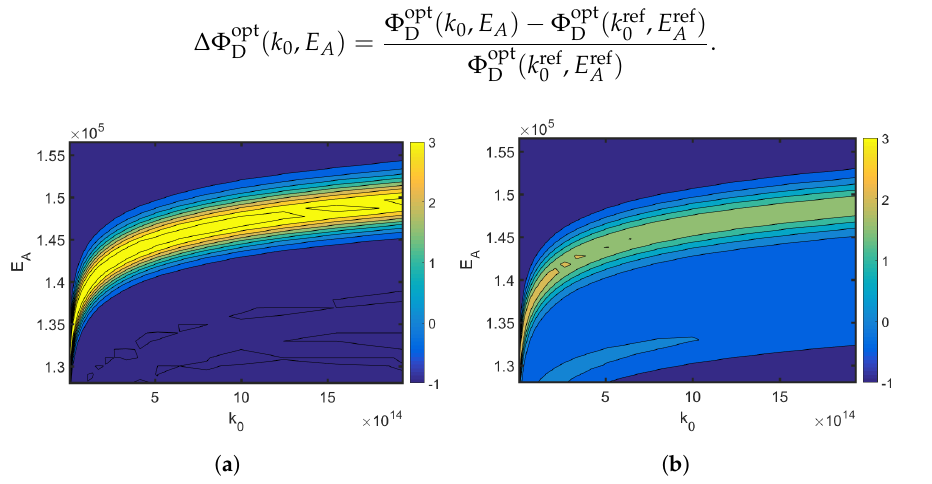
Figure 6. Effect of parameter variation. Areas close to zero mean no change in the optimized cost function (Equation (29)) when the Arrhenius parameters are changed. The classical D-optimality shown in ( a ) degrades drastically with parameter variations. The robust D-optimality shown in ( b ) is less affected by changes in the parameters. ( a ) D-optimality; ( b ) Robust